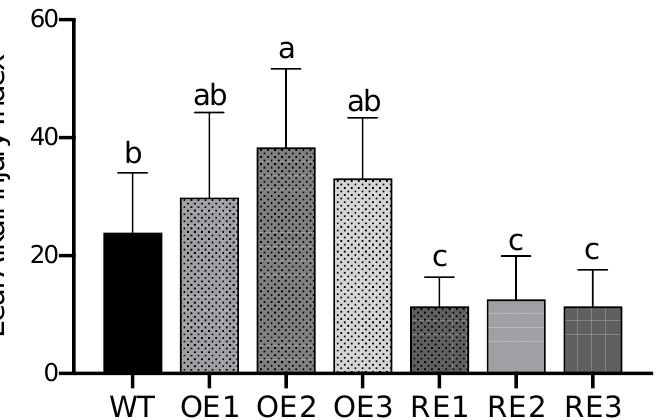
Figure 4. The difference of leaf alkali injury indexes among poplar transgenic and WT lines under NaHCO 3 stress treatment. The means and standard errors were calculated with six replications ( p < 0.05). Multiple comparison was used via Duncan test. Different letters indicate significant differences.